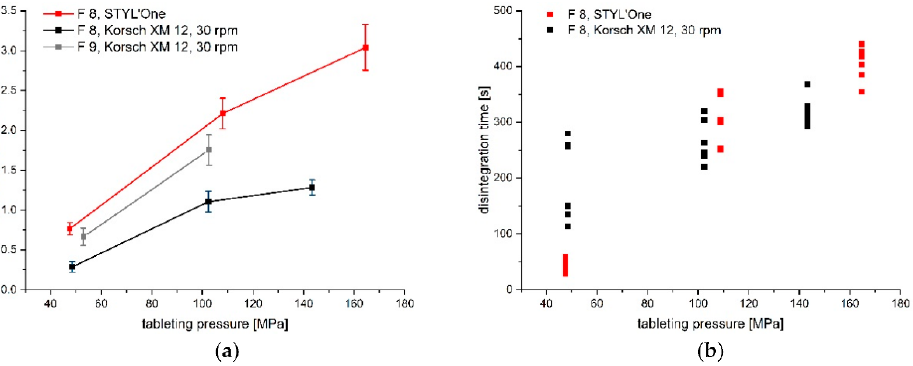
Figure 3. Comparison of ( a ) tabletability (mean ± CI ( α = 0.05), n = 10) and ( b ) disintegration times ( n = 6) of mini-tablets of F 8 produced on the STYL’One and on the Korsch XM 12; ( a ) also shows the tabletability (mean ± CI ( α = 0.05), n = 10) of F 9 produced on the Korsch XM 12.